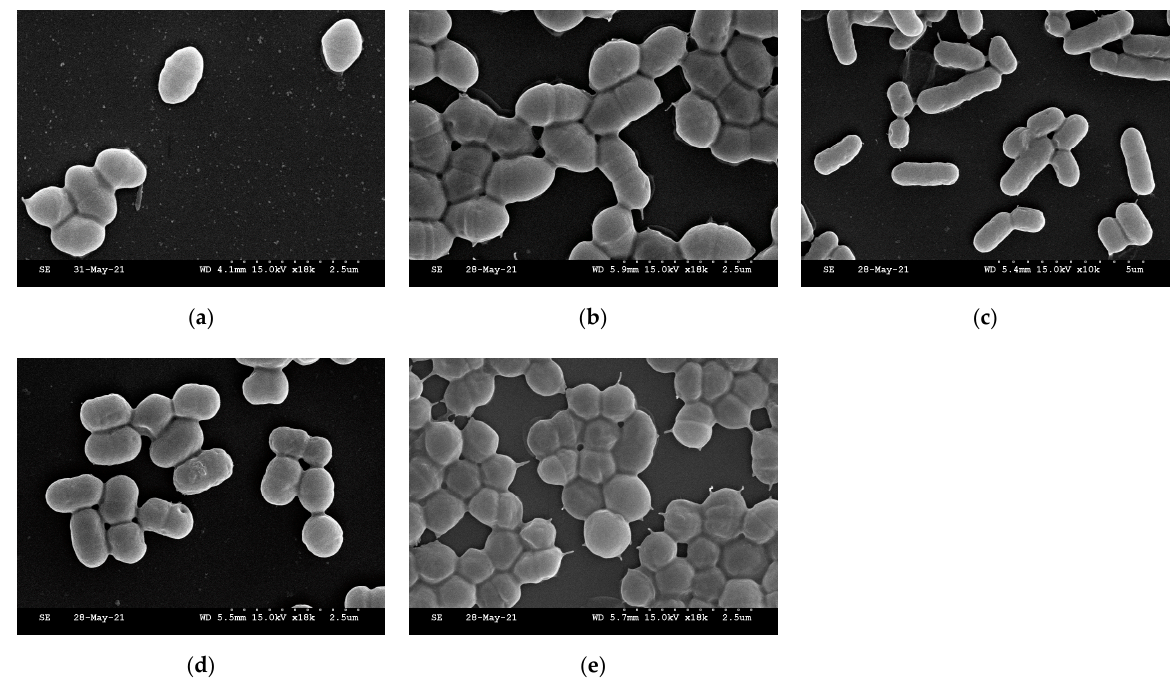
Figure 3. SEM images of selected strains. ( a ) E. faecium MG9003; ( b ) E. faecium MG9007; ( c ) L. reuteri MG9012; ( d ) L. fermentum MG9014; ( e ) P. pentosaceus MG9015.